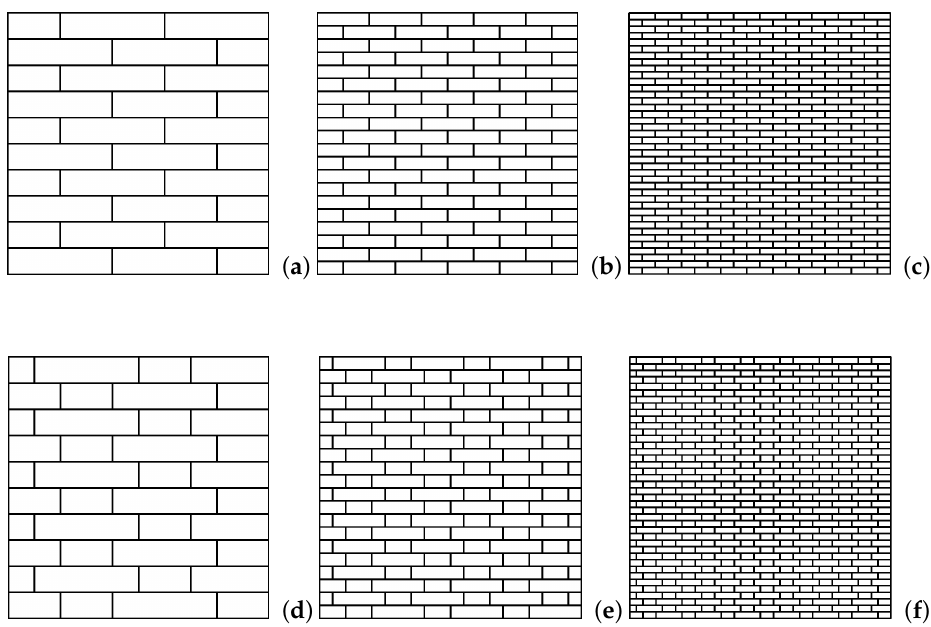
Figure 1. Rectangular microstructures. Texture 1: ( a ) s = 1 ( b ) s = 0.5 ( c ) s = 0.25. Texture 2: ( d ) s = 1 ( e ) s = 0.5 ( f ) s = 0.25. Reference Volume